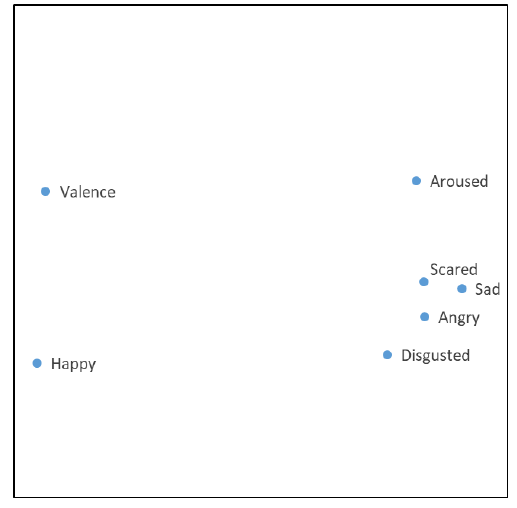
Figure 4. Visualization of a set of human emotions based on built environmental features.